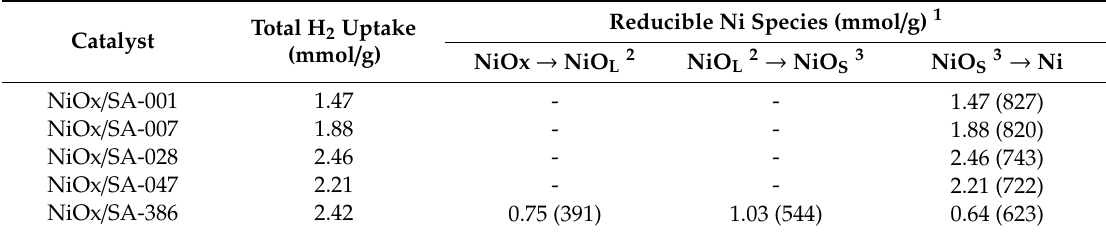
Figure 3. H 2 -TPR profiles of (A) NiOx / SA-001, (B) NiOx / SA-007, (C) NiOx / SA-028, (D) NiOx / SA-047, (E) NiOx / SA-386, and (F) SA-007. Table 2. The amount of reducible Ni species determined by H 2